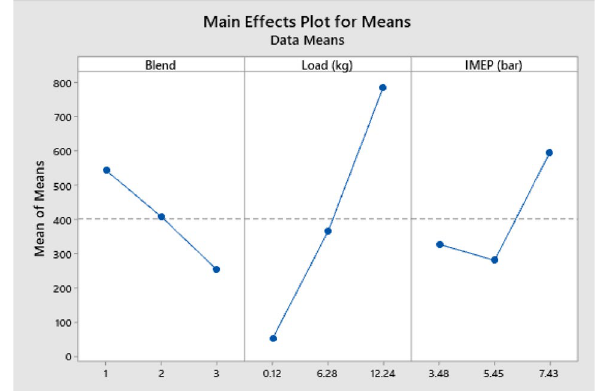
versus CuO (nano), load (kg), 2